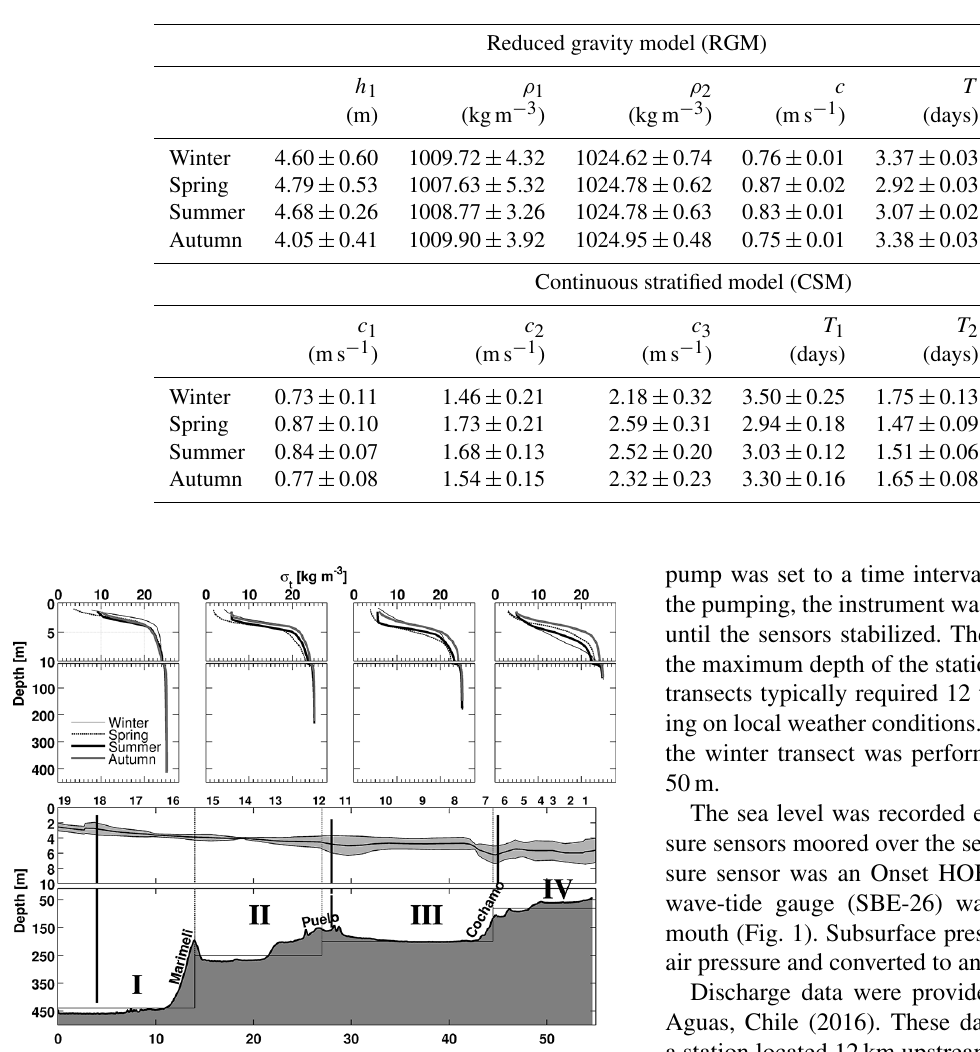
Table 2. Seasonal statistics of the descriptive parameters of the fjord. Here we present the mean depth of the upper layer ( h 1 ) and densities of the upper ( ρ 1 ) and deep layers ( ρ 2 ) . In addition, the phase and modal velocities ( c) and their periods ( T ) estimated using the reduced gravity and continuously stratified models are shown.